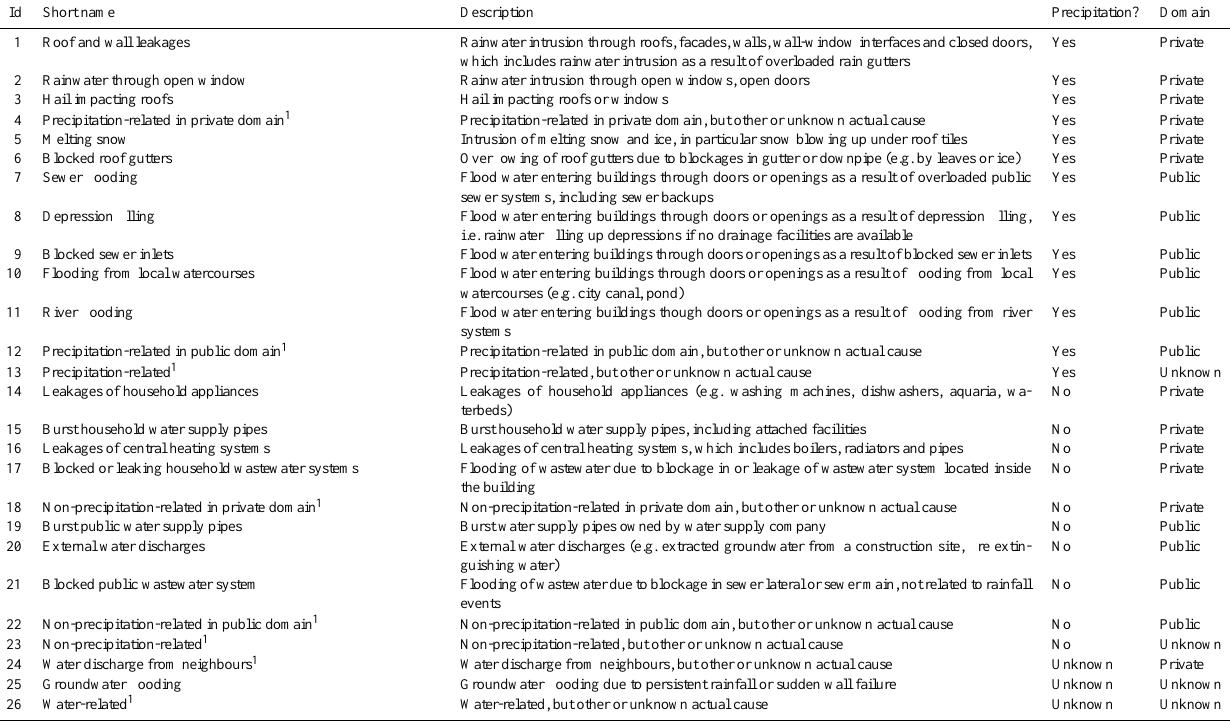
Table 3. Classification scheme of water-related failure mechanisms applicable to residential buildings. The column “Precipitation?” indicated if the claim is related to precipitation. The column “Domain” indicates whether damage prevention mainly concerns homeowners (private) or water authorities